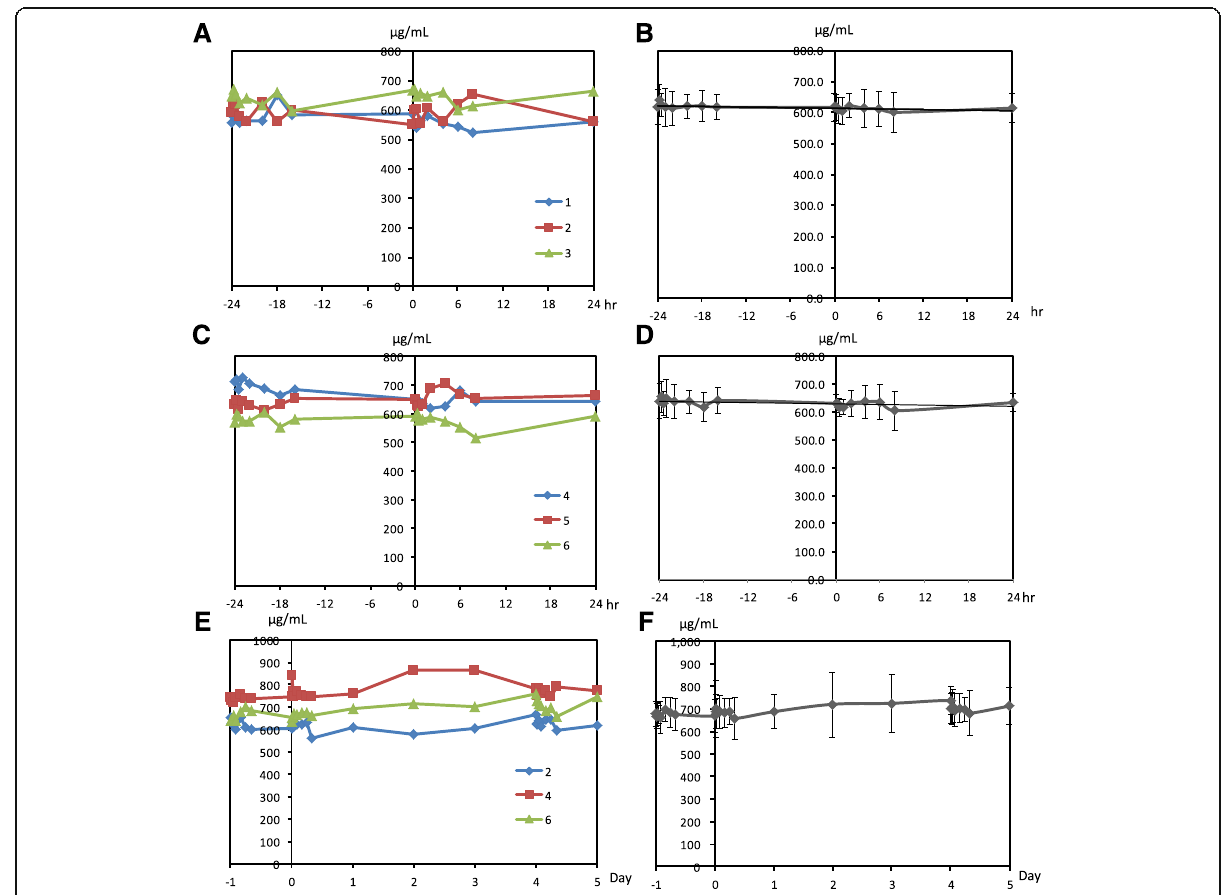
Fig. 3 Changes in serum total aceneuramic acid concentrations measurement (Trial-1). In Trial-1, total aceneuramic acid that is aceneuramic acid combined with protein or lipid as well as free aceneuramic acid was measured. Since physiologically existing total aceneuramic acid is also measured, no increase in the concentration after administration was observed in each case. a . Single administration trial for each